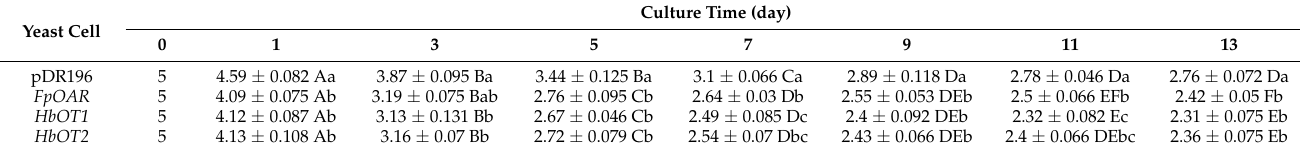
Table 2. The pH variation of culture solution for yeast transformants containing pDR196 empty vector (negative control), FpOAR (positive control), HbOT1 , and HbOT2 under 13 days’ 2 mmol/L oxalic acid stresses.